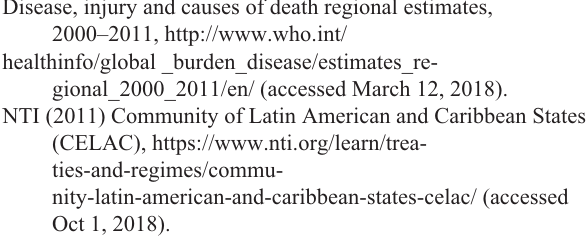
Figure S1 - Risk of bias by domain from all case-control studies Figure S2 - C677T Heterozygous Model Figure S3 - C677T Homozygous Model Figure S4 - C677T Dominant Model Figure S5 - C677T Recessive Model Figure S6 - C677T Allelic Model Figure S7 - Sensitivity Analysis for C677T Models Figure S8 - Publication Bias for C677T for Models Figure S9 - A1298C Heterozygous Model Figure S10 - A1298C Homozygous Model Figure S11 - A1298C Dominant Model Figure S12 - A1298C Recessive Model Figure S13 - A1298C Allelic Model Figure S14 - Sensitivity Analysis for A1298C Models Figure S15 - Publication Bias for A1298C for Models Table S2 - Search used for MTHFR polymorphisms and cancers that focus on the Latino population Table S3 - Assessment study quality based on the Newcas- tle-Ottawa